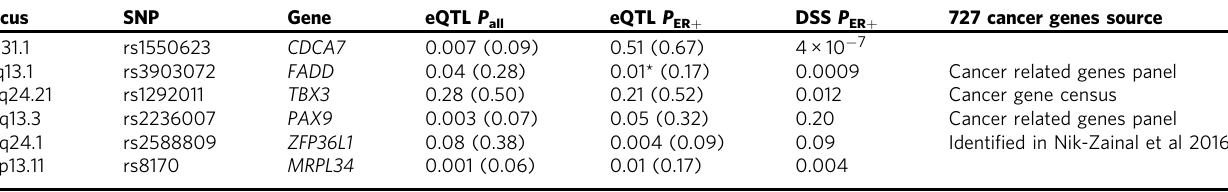
Table 4 Six CHi-C putative target genes for which there was orthogonal support for at least two additional data sources